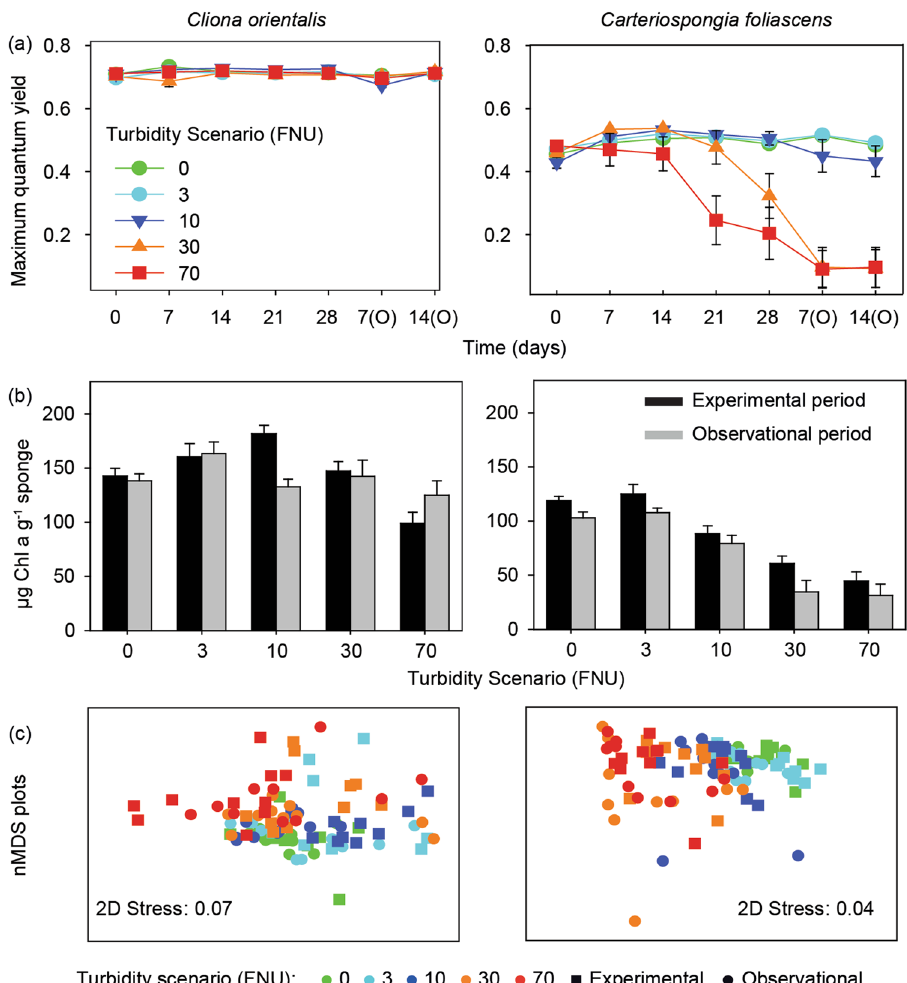
Figure 4. Photosymbiont response to the 5 different scenarios. ( a ) Mean values ( ± SE) of maximum quantum yield, ( b ) Mean values ( ± SE) of Chl a , and ( c ) Non-metric Multi-Dimensional Scaling (nMDS) of all photopigments retrieved by spectrophotometry, for the two phototrophic species and for all scenarios in the experimental and observational